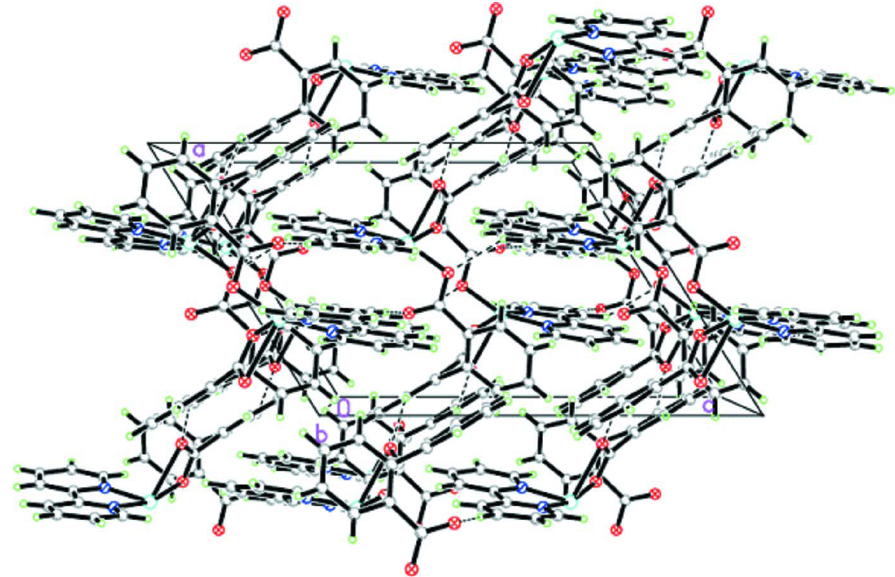
Figure 1 View of the structure of compound (I), showing the atom-labelling scheme. Displacement ellipsoids are drawn at the 35% probability level; H-atoms are shown as small spheres of arbitrary radius.